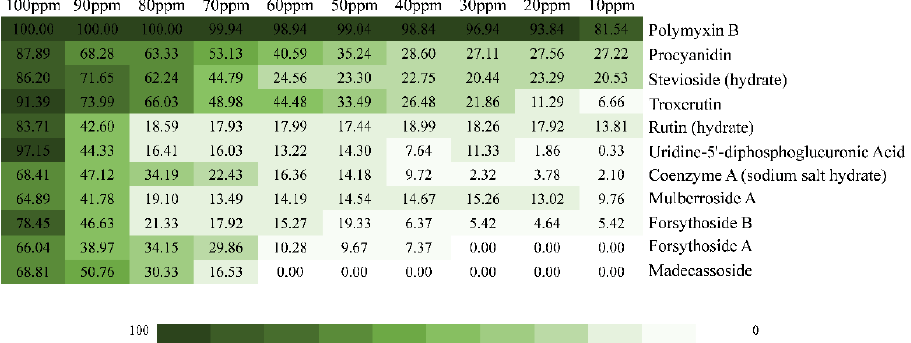
3 of 17 Figure 1. Homology model of V. parahaemolyticus LolB protein. ( A ): V. parahaemolyticus LolB (resi- dues 36-211) modeled by Swiss-model. ( B ): Superposition of V. parahaemolyticus LolB model (green) with E. coli LolB crystal structure (cyan, PDB 1IWM). The rmsd was 0.374 over 137 C α . ( C ): Super- position of V. parahaemolyticus LolB model (green) with full-length structure of V. parahaemolyticus LolB (yellow) predicted by Alphafold. The rmsd was 1.033 over 141 C α . Table 1. The top 10 compounds targeting LolB obtained from virtual screening. Number